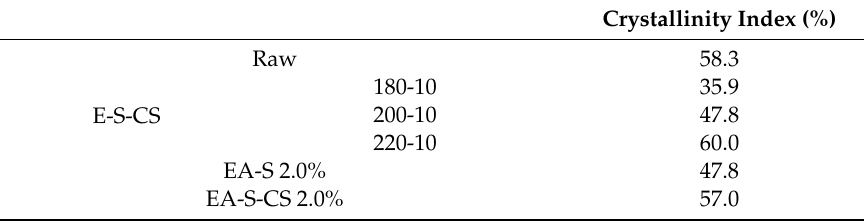
Figure 4. X-ray di ff raction of ( A ) E-S-CS and ( B ) EA-S and follow-up EA-S-CS. Table 6. X-ray di ff raction of ( A ) E-S-CS and ( B ) EA-S and follow-up EA-S-CS.